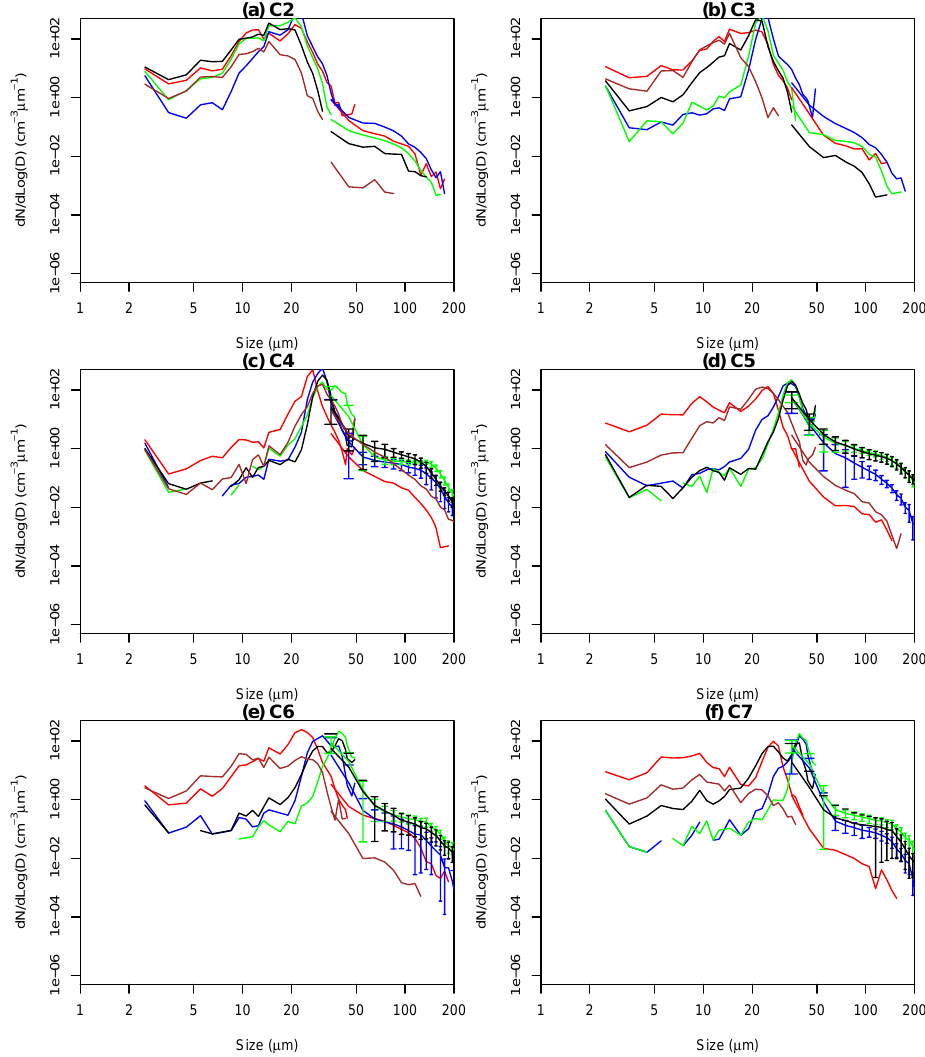
Fig. 6. Integrated size distribution of cloud particles from CDP and 2D-S for clouds 2–7. The traverse of a cloud is divided equally to 8 parts in the horizontal direction. The averaged distributions in five areas are shown for each cloud. These 5 areas are: the first part (the upshear side, in red), the second and the third parts (in blue), the 4th and the 5th parts (the cloud core, in green), the 6th and 7th parts (in black), and the 8th part (the downshear side, in brown). The ranges of standard deviation are added for clouds C4–C7 for particles larger than